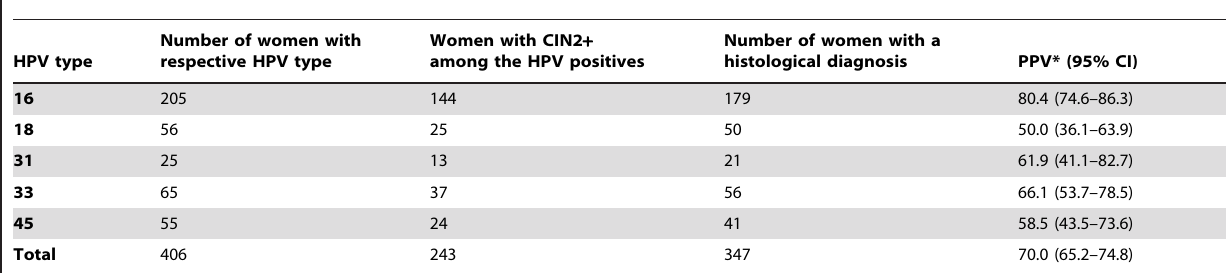
Table 2. PPV for CIN2 + for the different HPV-types, including all ages.